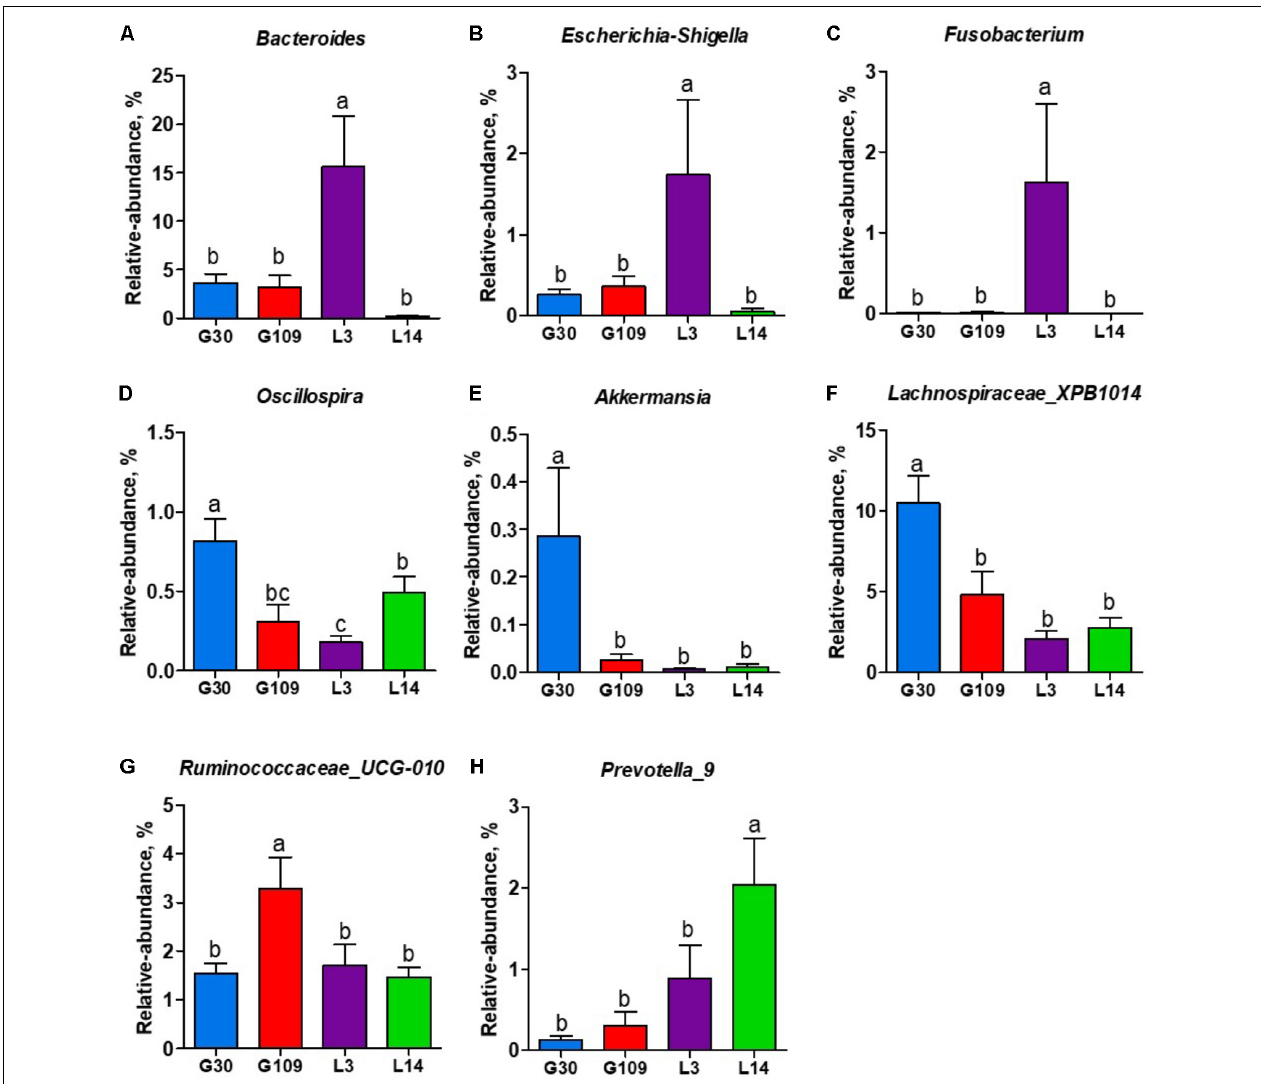
FIGURE 3 | The changes of 7 distinct genera in the gut microbiota composition of sows across the reproductive cycle. (A) Bacteroides, (B) Escherichia-Shigella , (C) Fusobacterium , (D) Oscillospira , (E) Akkermansia , (F) Lachnospiraceae_XPB1014 , (G) Ruminococcaceae_UCG-010 , and (H) Prevotella_9 . Data are presented as means ± SEM ( n = 12). a–c, significant effect of sampling day (values with different lowercase letters are significantly different). G109, day 109 of gestation; L3, day 3 of